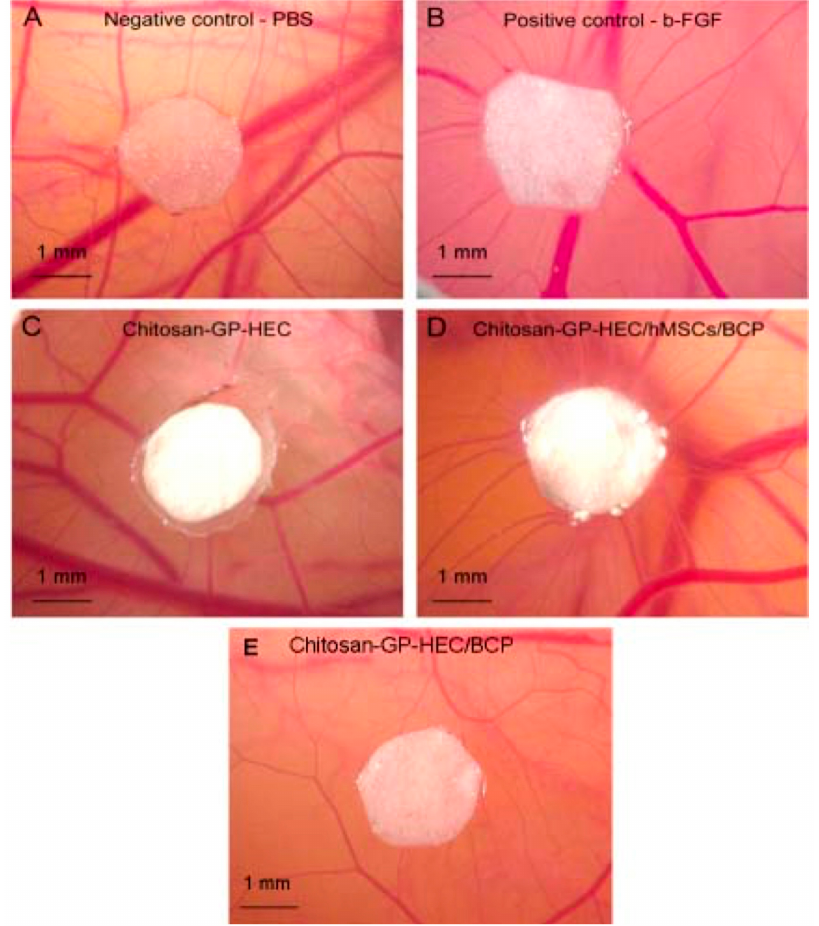
Figure 2. Extent of angiogenesis developed after three days of incubation with ( A ) PBS (negative control), ( B ) b-FGF (positive control), ( C ) CS-GP (glycerol phosphate)-HEC (hydroxyethyl propyl cellulose) hydrogel, ( D ) CS-GP-HEC/hMSCs (human derived mesenchymal stem cells)/BCP (biphasic